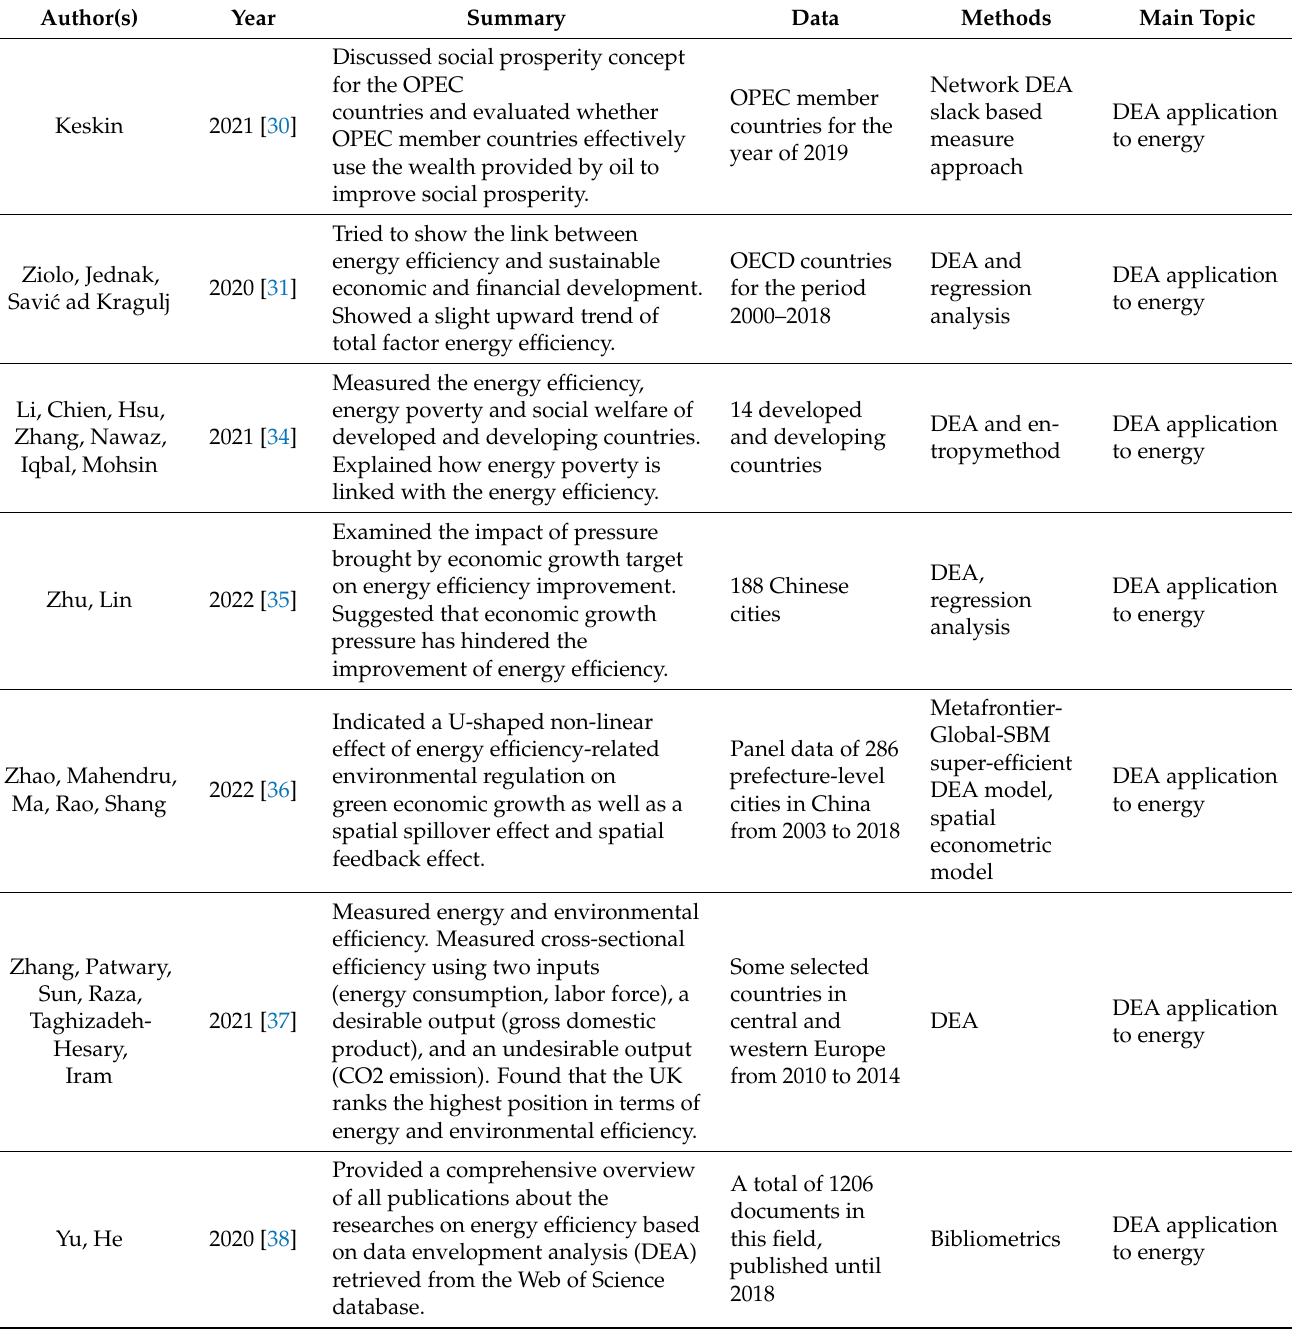
Table 2. References on DEA applied to energy studies